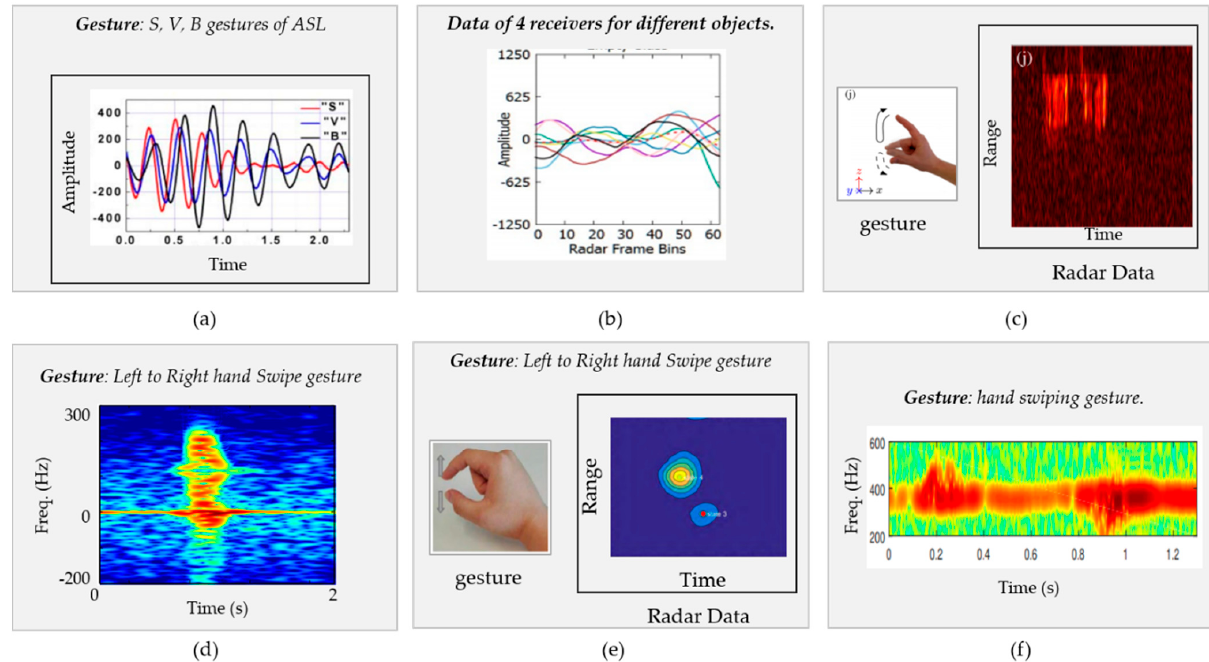
Figure 7. Hand-gesture data representation examples; ( a ) Time–Amplitude [51]: ASL radar data for S, V, B gesture. ( b ) Range–Amplitude [75] data of different objects touching radar ( c ) Time–Range variations [38] of finger-swiping gesture ( d ) Time–Doppler [54] frequency vitiation for left–right swipe ( e ) Range–Doppler ( f ) Time–Frequency representation [67].